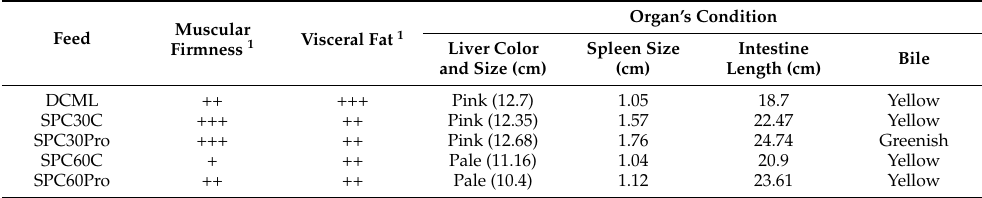
Table 3. Organs condition in fish fed with SPC treatments and Bacillus subtilis 9b strain.